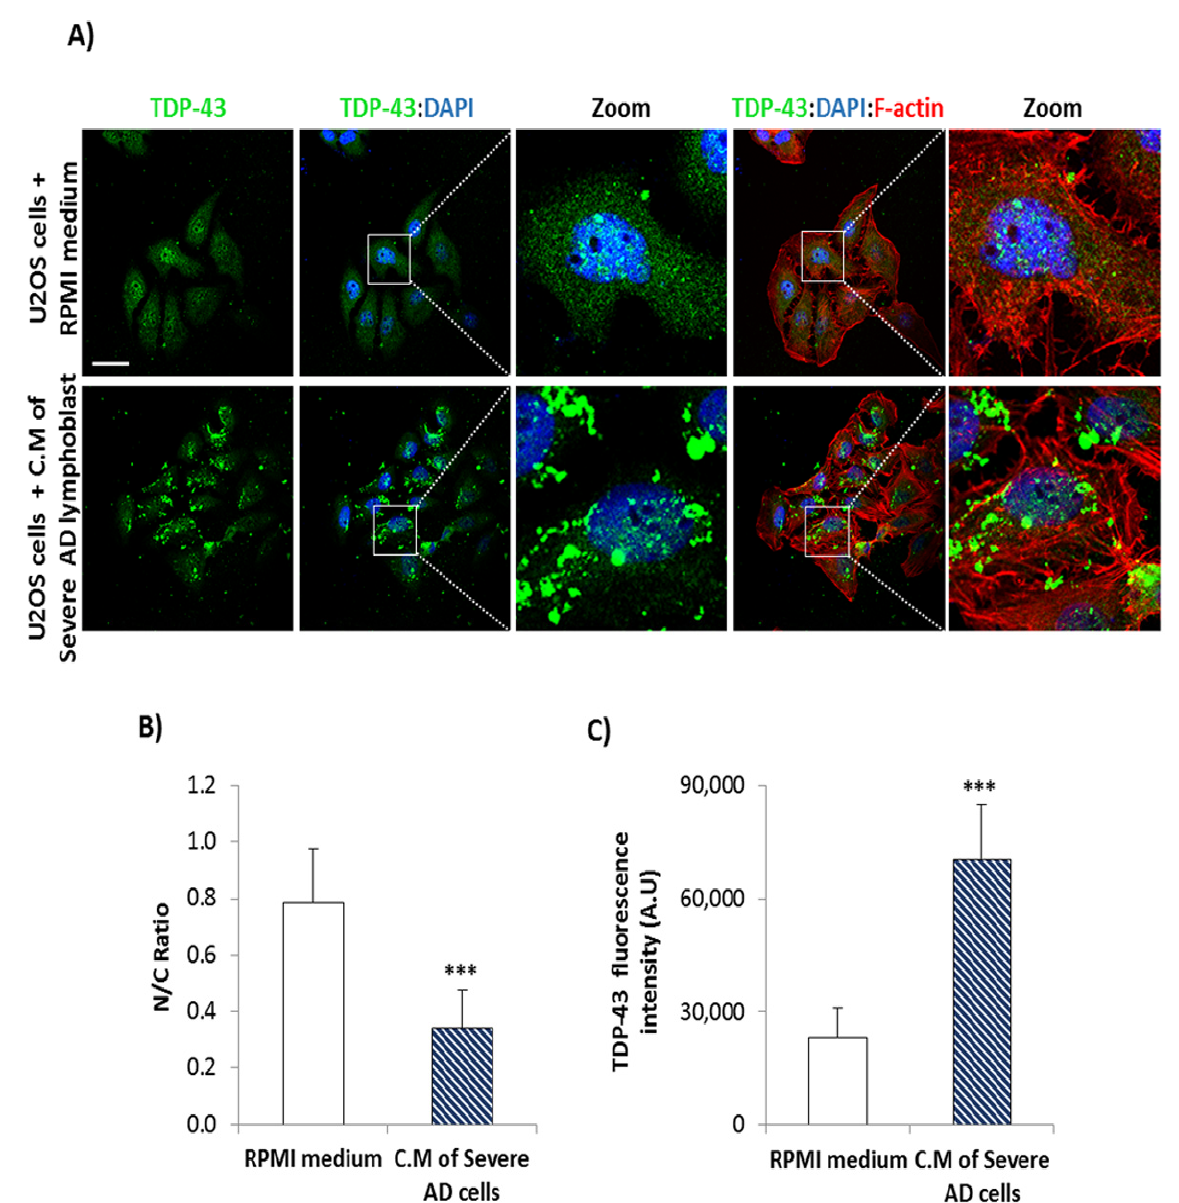
Figure 6. Conditioned medium (CM) of AD lymphoblasts induces TDP-43 pathology in U2OS osteosarcoma cells. ( A ) Confocal immunofluorescence images of TDP-43 (green), F-actin (red) and DAPI staining (blue) in U2OS cells treated with RPMI medium or CM of severe AD lymphoblasts for 72 h. Scale bar, 40 µm. ( B ) Nucleo-cytoplasm ratio (mean nuclear intensity divided by the mean cytoplasmic intensity) and ( C ) fluorescence intensity was measured cell to cell using Image J software in at least 4 fields of view. (A.U, arbitrary units). Bars are the mean ± SD of two independent experiments. Statistical analysis was performed using the Student t test. (*** p < 0.001).